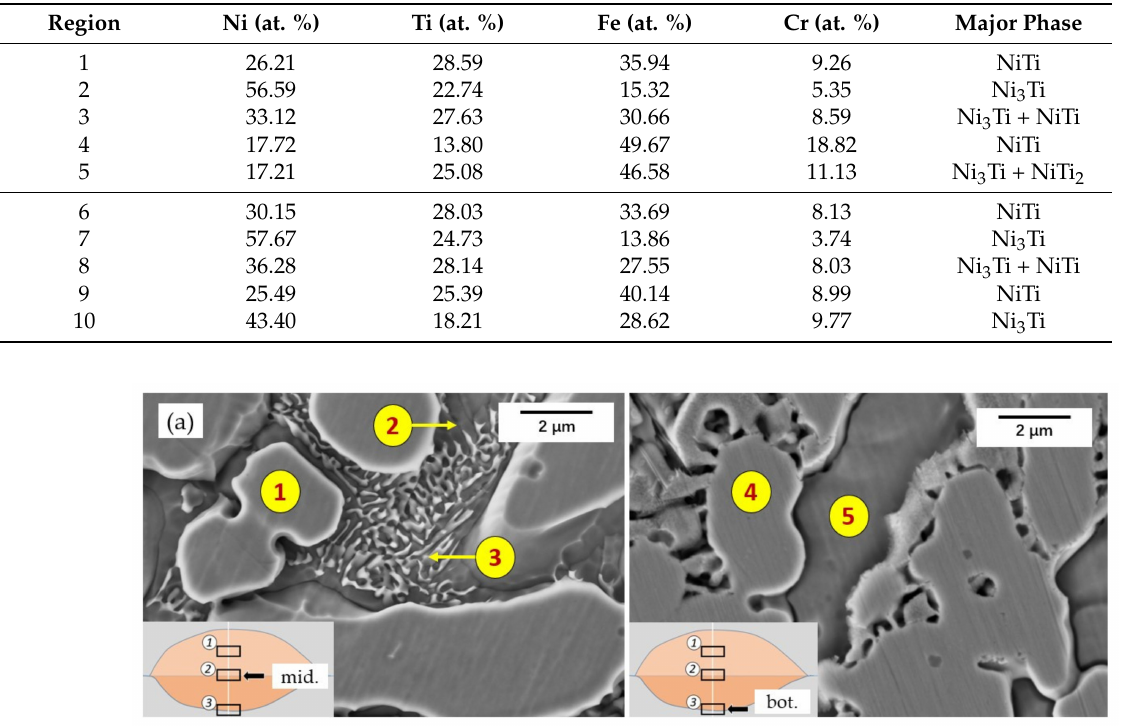
Figure 9. Gibbs free energy of Ni–Ti intermetallic compound. Table 4. EDS results of different regions marked in Figure 10.